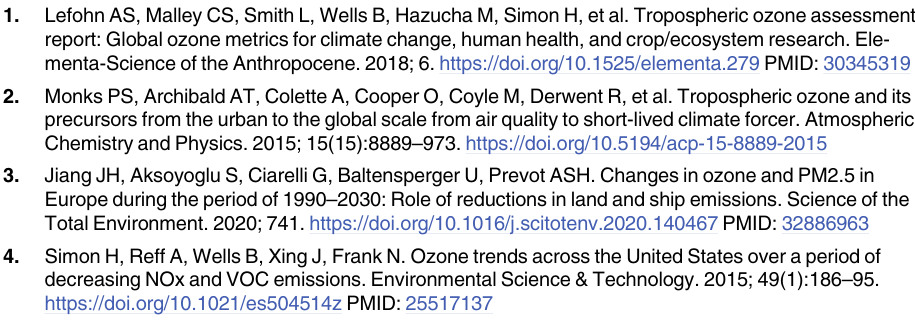
treatment, leaf position, mesophyll layer 3 treatment � leaf 3